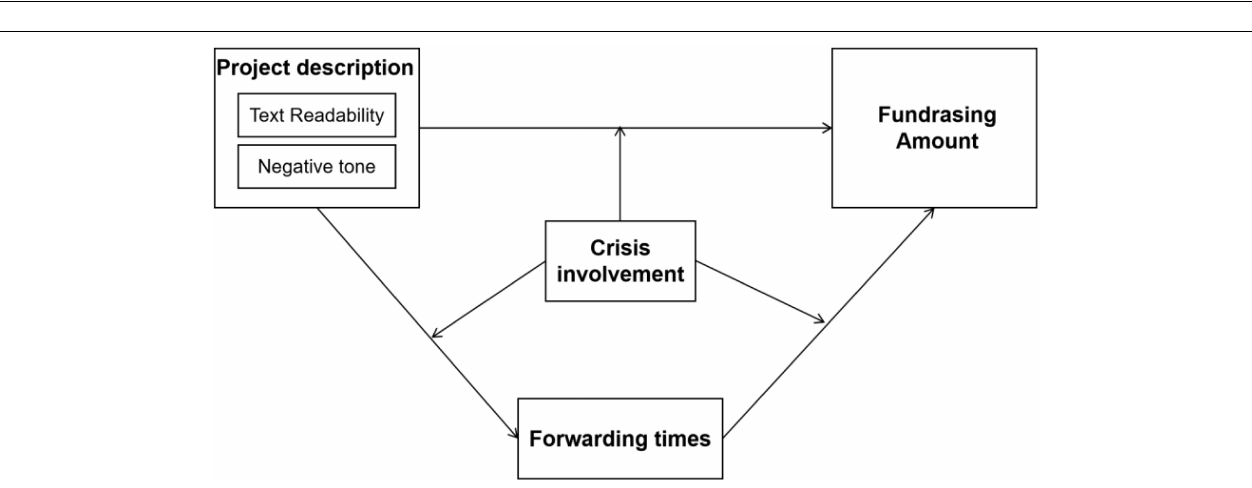
FIGURE 2 | Conceptual